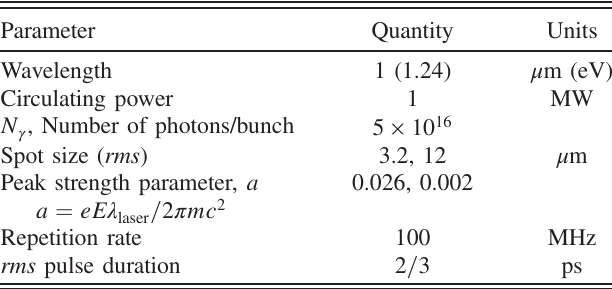
TABLE II. Laser parameters at interaction